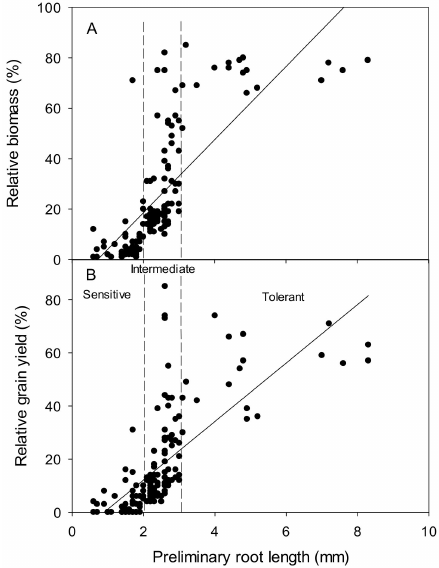
Figure 4. Root length as determined with the rapid screen identifies Al 3 + -tolerant accessions based on both mature biomass ( A ) and grain yield ( B ). The preliminary root length is a measure of the total root length of the most tolerant seedling in the pool of seedlings assessed for each accession. The